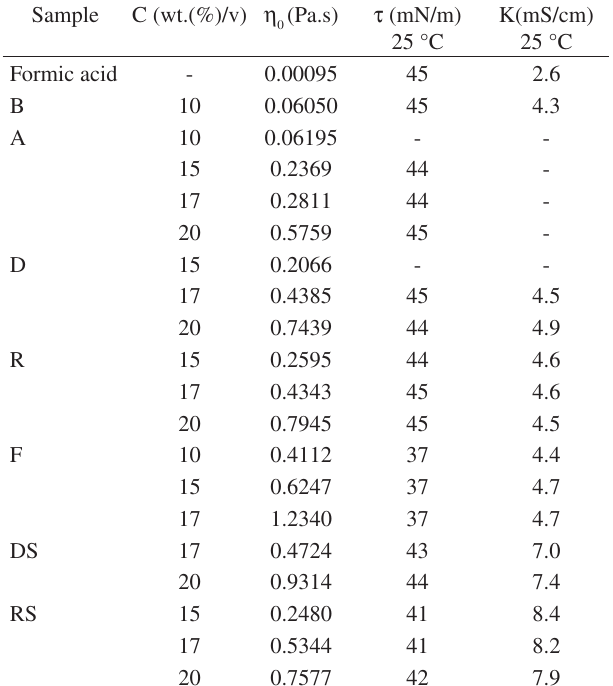
Table 7. Zero shear viscosity, η K, of the polyamide 66